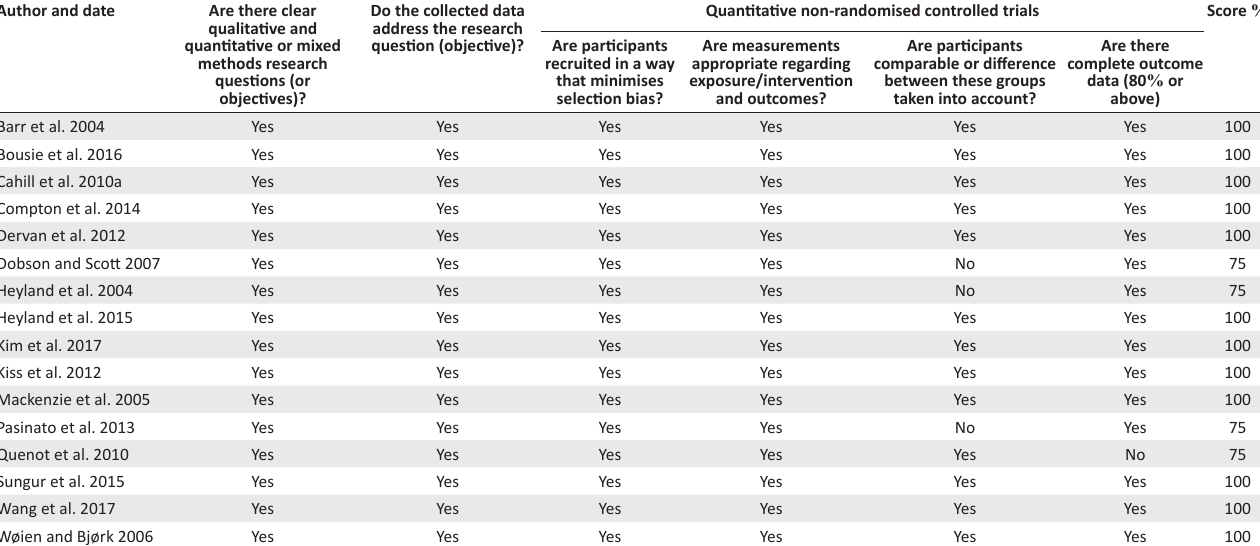
TABLE 4: Summary of quality assessment report of included studies from databases (MMAT